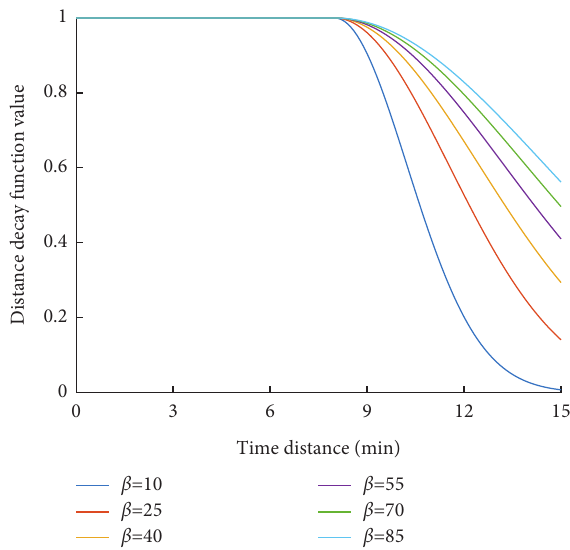
Figure 1: The distance decay function with different impedance